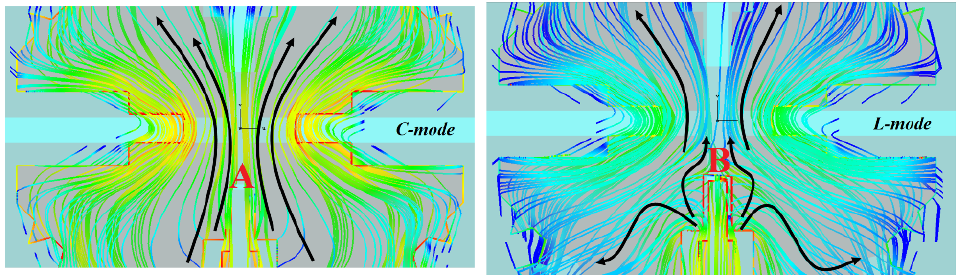
Figure 3. Simulated electric-field streamlines in C-mode and L-mode.